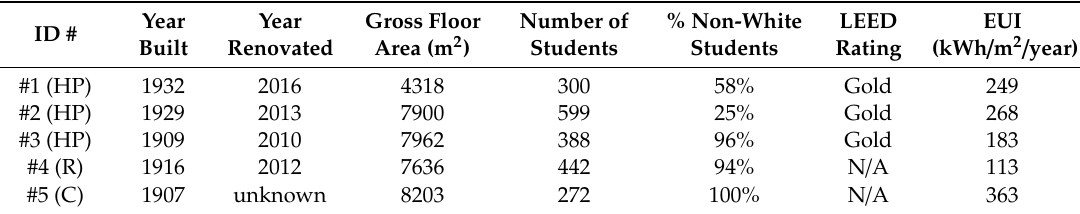
Table 2. Case-Study Building Descriptions.